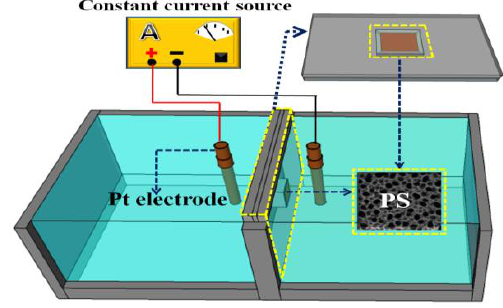
Figure 1. Schematic diagram of the Teflon double-tank cell.